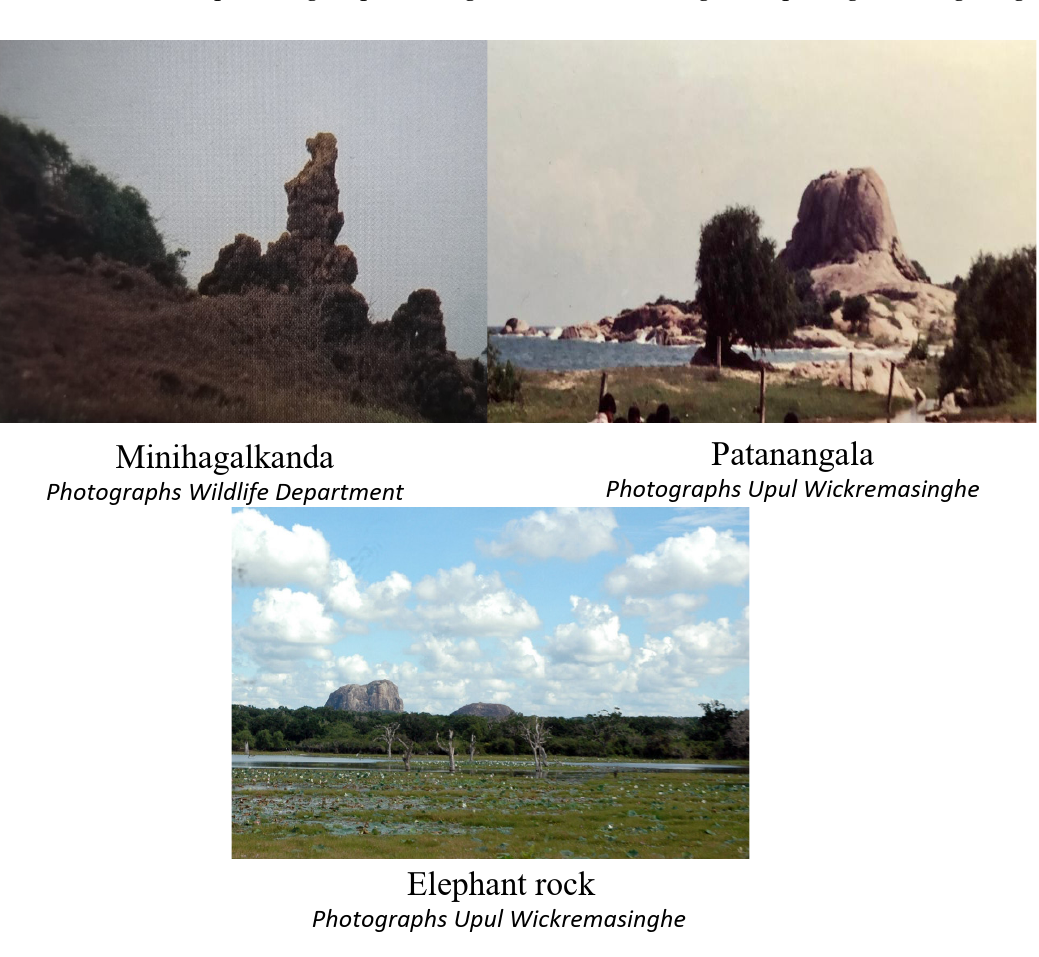
Figure 2. Potential sites for geotourism development in Yala National Park, Sri Lanka. Table 1. Key features of selected geotourism sites at Yala National Park, Sri